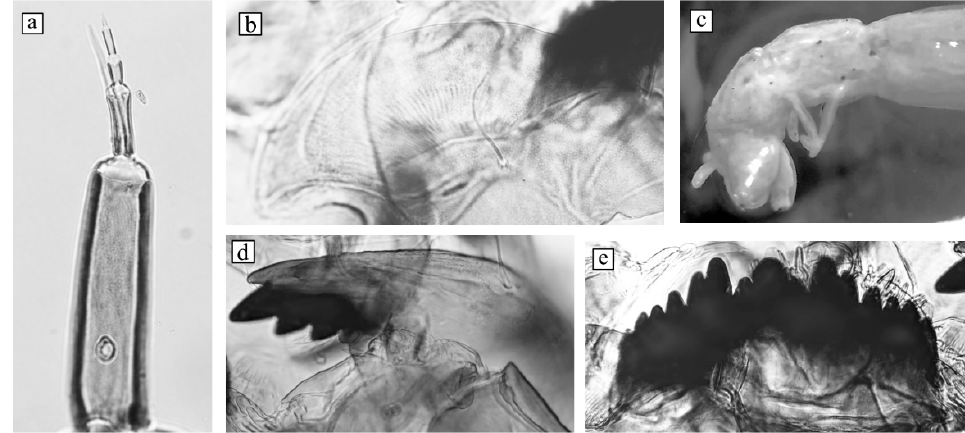
Figure 2. Larval morphology of Ch. laetus from the Yamal Peninsula, Russia. a —antenna, b —ven- tromental plate, c —abdominal apex, d —mandible, and e —mentum.